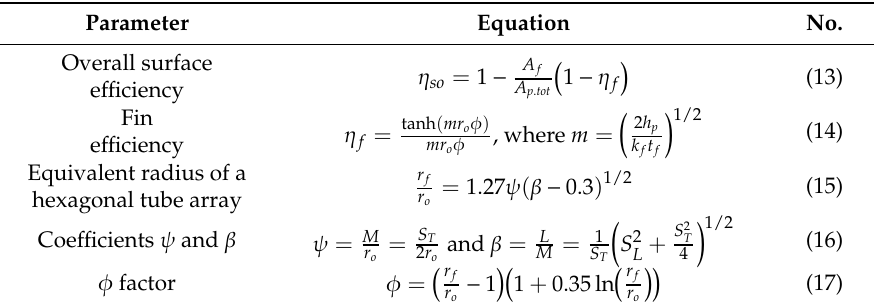
Table 3. Overall product air-side surface e ffi ciency